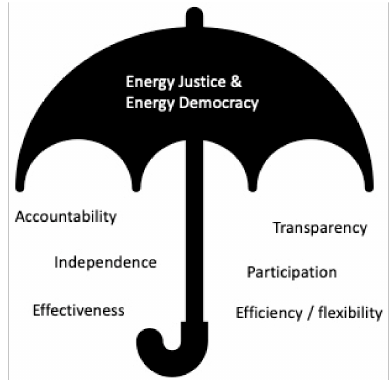
Figure 1. Umbrella function of energy justice and energy